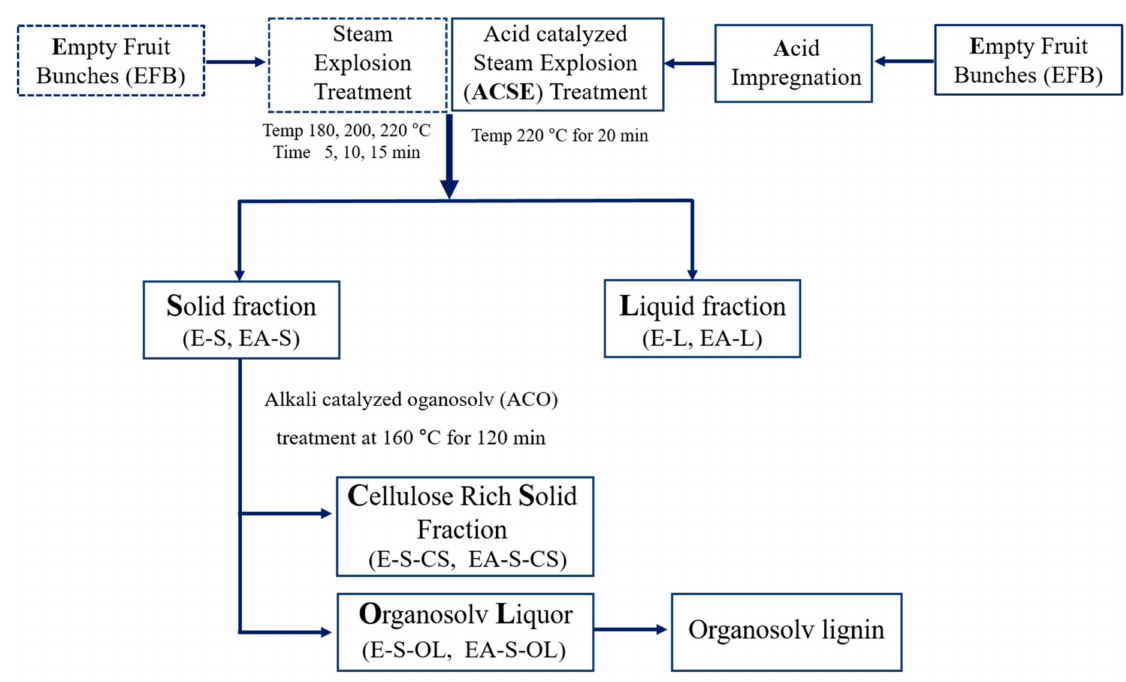
Figure 1. Schematic diagram of the two-step fractionation process of empty fruit bunches (EFB) by (acid-catalyzed) steam treatment followed by alkali-catalyzed organosolv